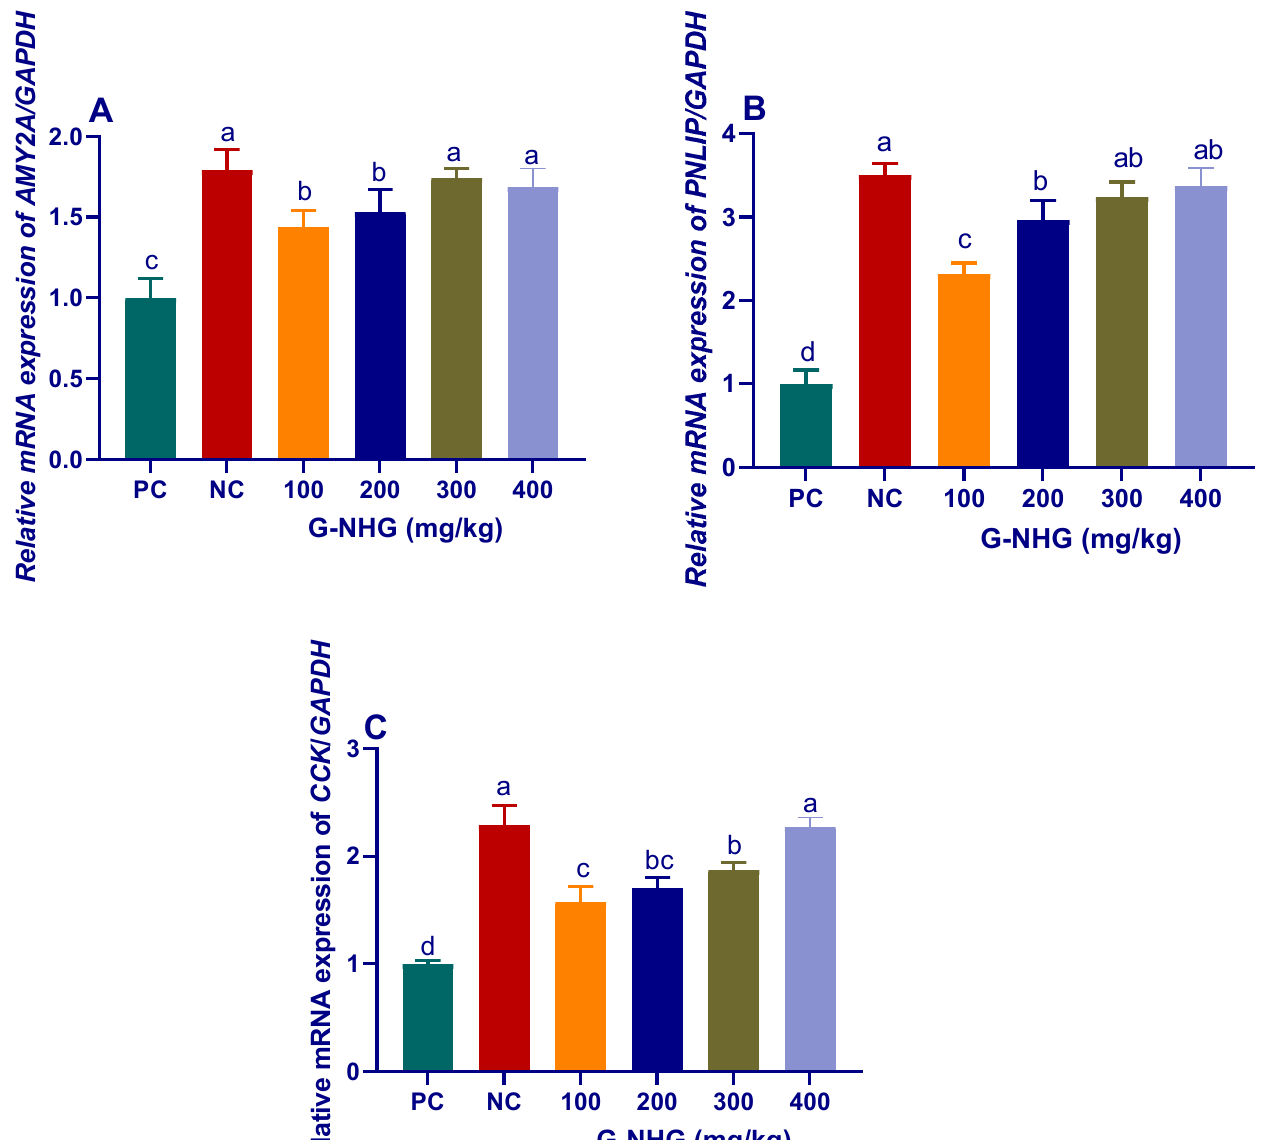
Figure 2. Levels of alpha 2A amylase ( AMY2A , A ), pancreatic lipase ( PNLIP , B ) and cholecystokinin ( CCK , C ) mRNA expression in broiler chickens fed different levels of G ‐ NHG and challenged with C. perfringens on d 21, 22 and 23 of the experiment as measured by RT ‐ qPCR assay. Values are means with their SE in bars. PC (positive control): birds fed a basal diet and challenged with C. perfringens , NC (negative control): birds fed a basal diet, G ‐ NHG (100, 200, 300 or 400 mg/kg) ‐ treated groups: birds fed a basal diet supplemented with 100, 200, 300 or 400 mg/kg of garlic nanohydrogel and challenged with C. perfringens . a–d Means within the same column carrying different superscripts are significantly different at p < 0.05.